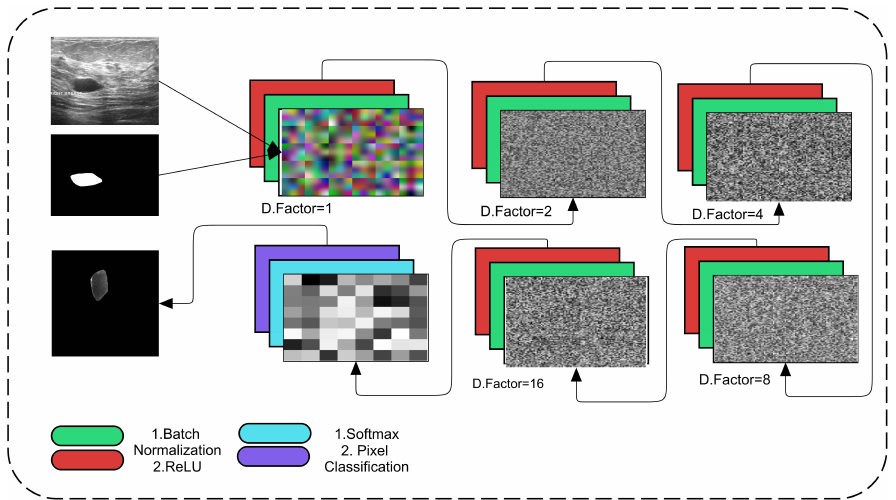
Figure 2. Proposed Dilated Semantic CNN